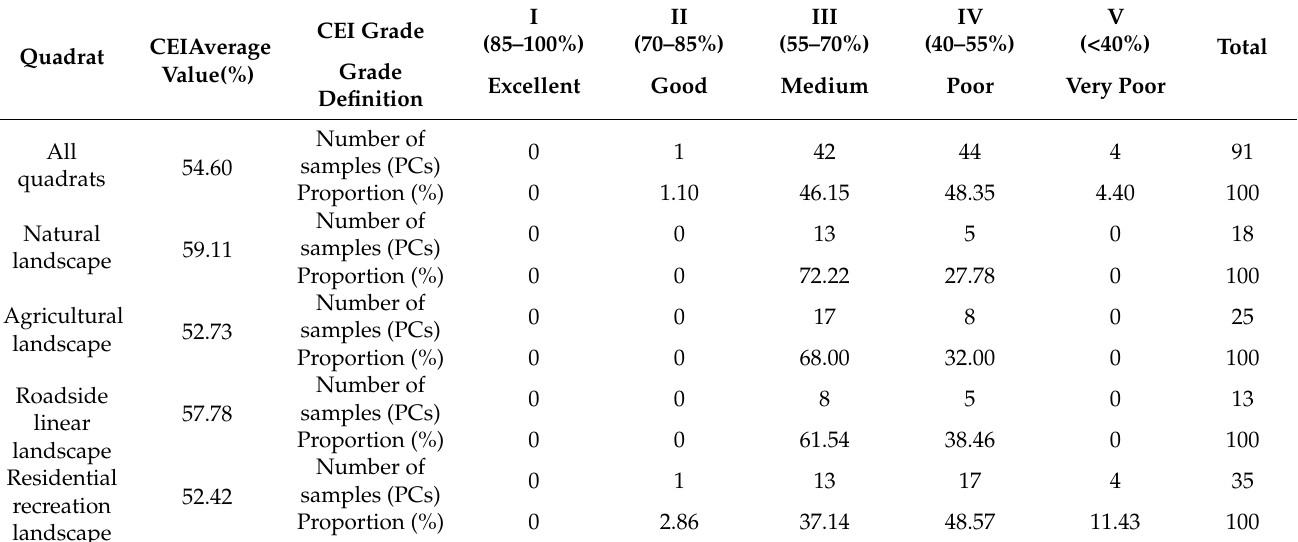
Table 7. Statistical table of plant landscape classification CEI level (source: